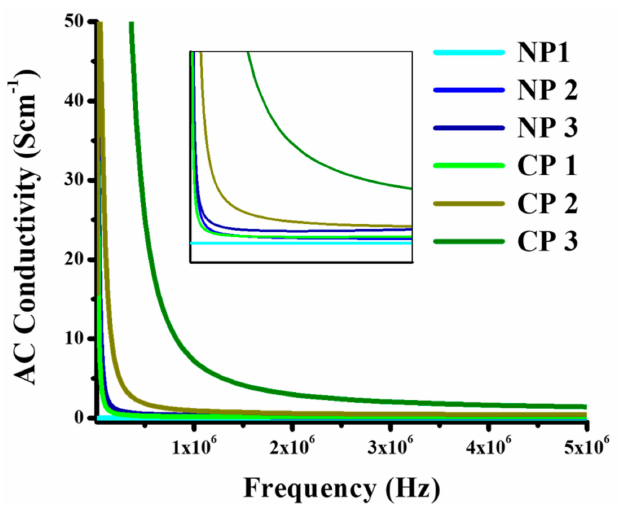
Figure 9. AC conductivity, PVA/NiO (0.2 wt%), PVA/NiO (0.4 wt%), PVA/NiO (0.6 wt%), PVA/CuO (0.2 wt%), PVA/CuO (0.4 wt%), PVA/CuO (0.6